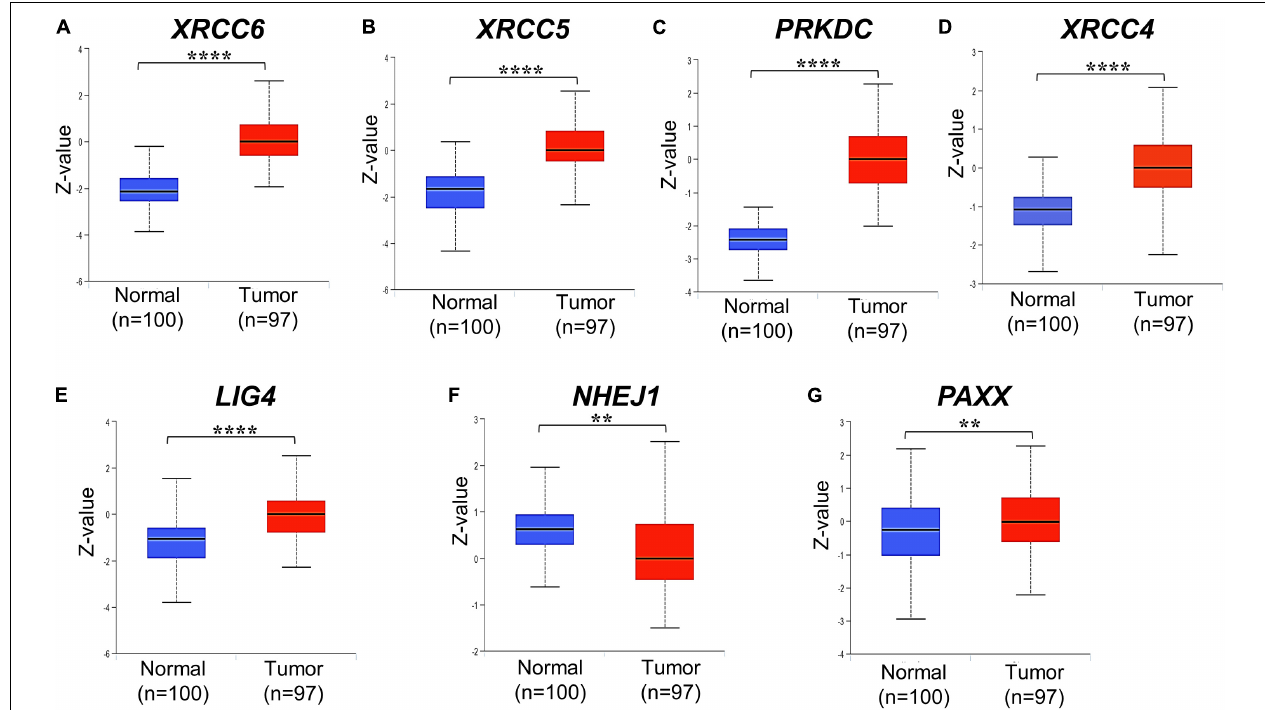
FIGURE 2 | Total protein levels of NHEJ pathway genes in normal tissues and colon cancer tissues from CPTAC study, including (A) XRCC6 (B) XRCC5 (C) PRKDC (D) XRCC4 (E) LIG4 (F) NHEJ1 and (G) PAXX. * p < 0.05, ** p < 0.01, *** p < 0.001, **** p < 0.0001.